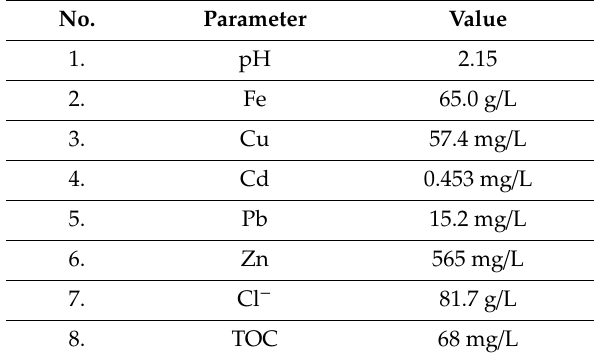
Table 1. Physicochemical characterization of the acidic residual solution. No.